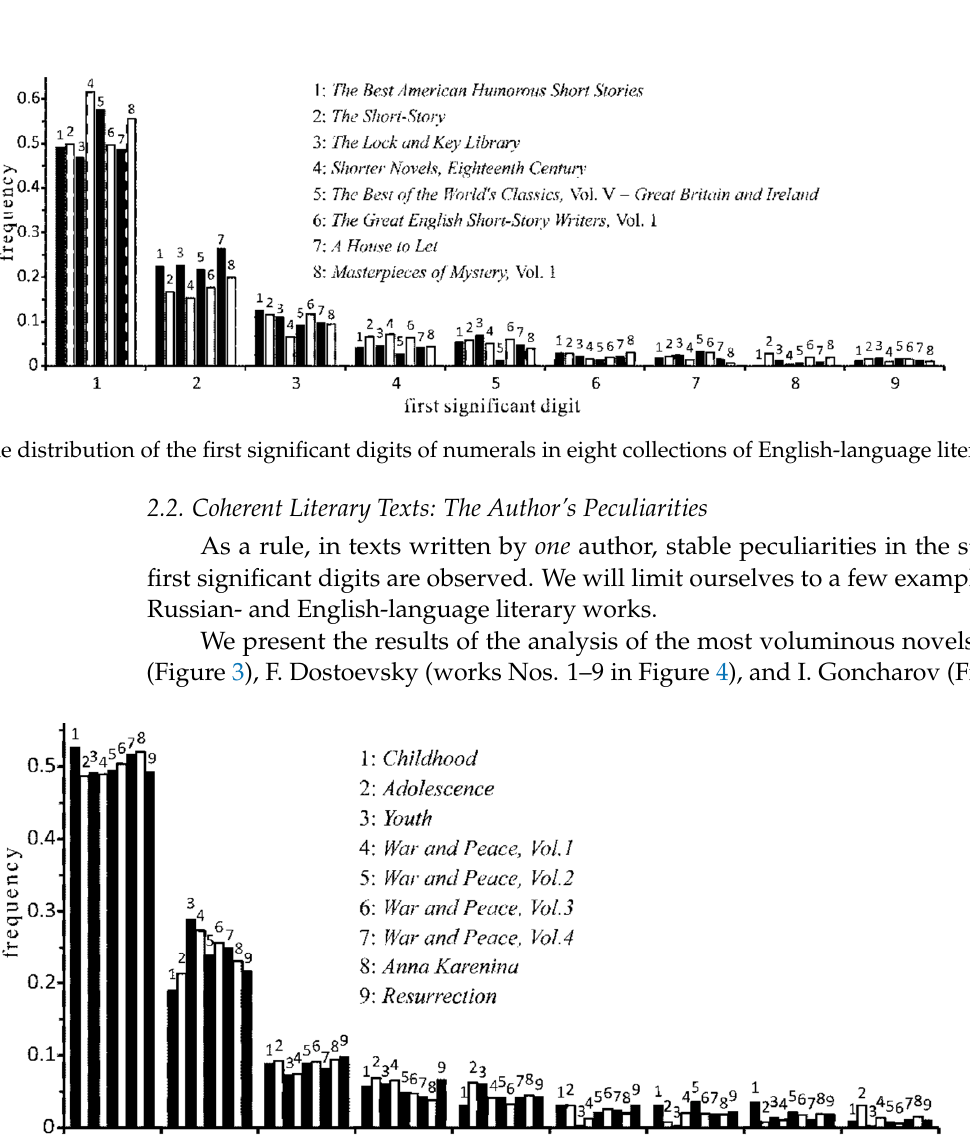
Figure 1. The frequency distribution of the first significant digits of numerals in three collections of Russian-language literary texts. Results are compared with those prescribed by Benford’s Law.